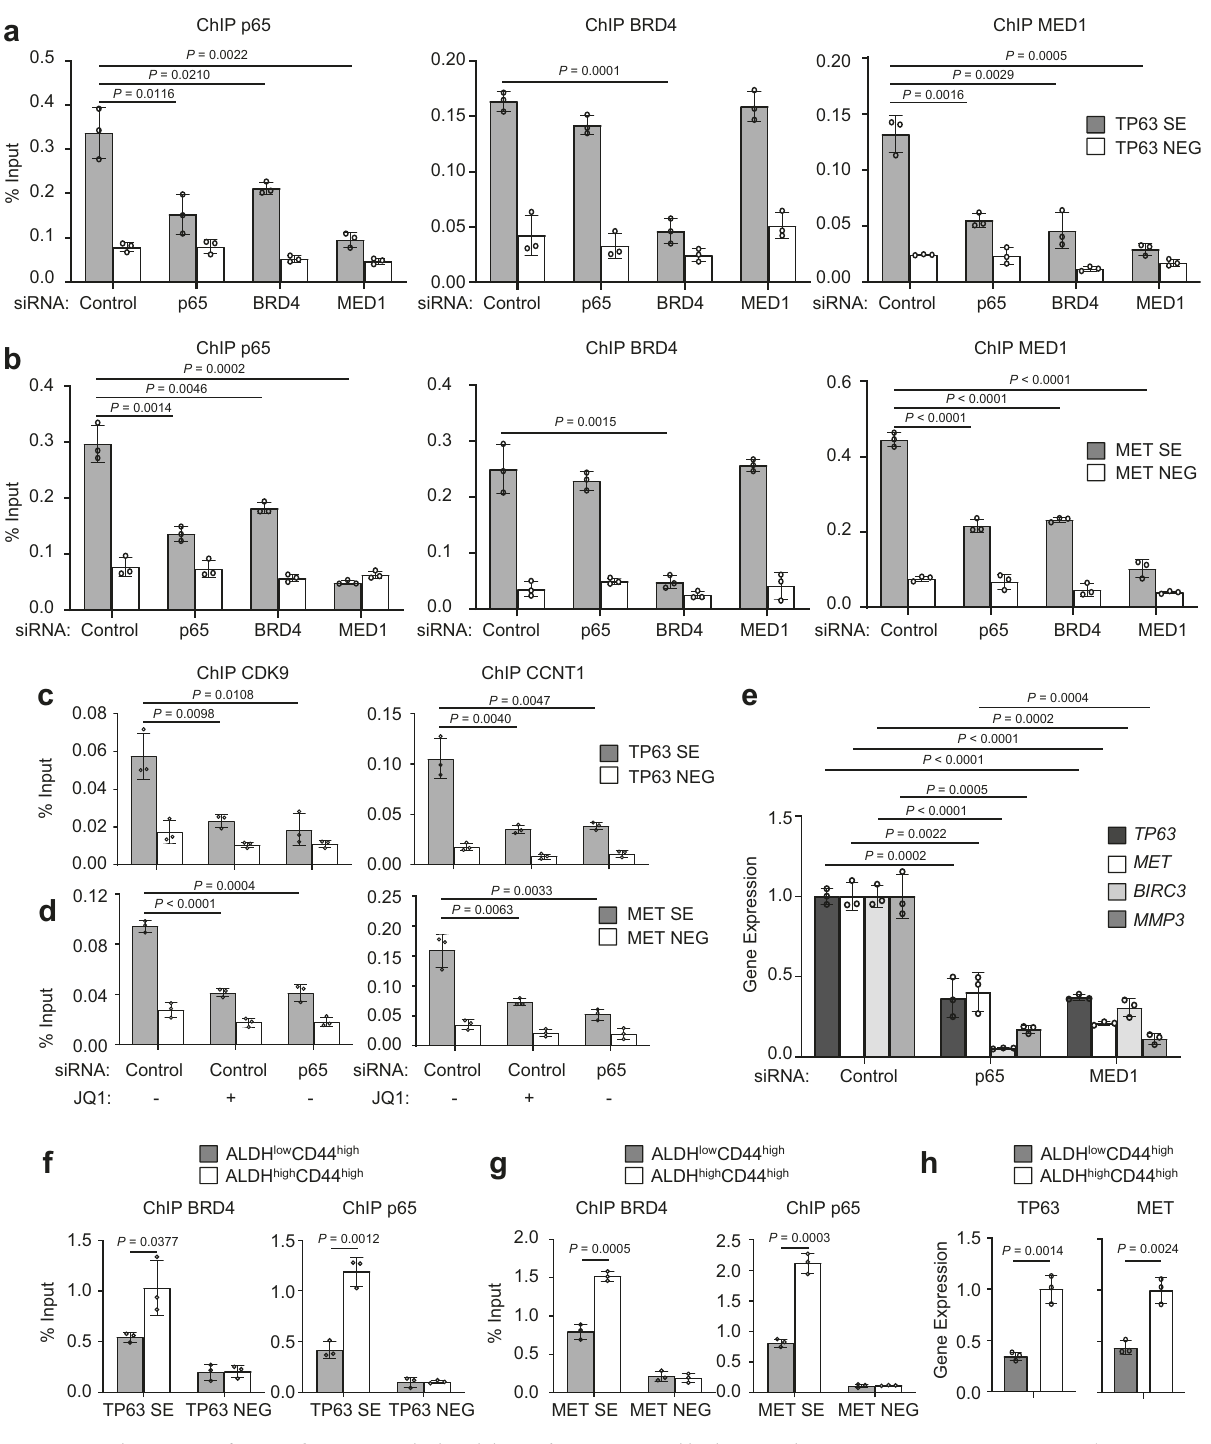
Fig. 4 BRD4 recruits MED1 and p65 to form SEs. a The knockdown of BRD4 impaired both p65 and MED1 recruitments to SEs in TP63 ( n = 3 per group). b The knockdown of BRD4 impaired both p65 and MED1 recruitments to SEs in MET ( n = 3 per group). c JQ1 treatment or p65 knockdown signi fi cantly inhibited the recruitment of both CDK9 and CCNT1 to SEs in TP63 ( n = 3 per group). d JQ1 treatment or p65 knockdown signi fi cantly inhibited the recruitment of both CDK9 and CCNT1 to SEs in MET ( n = 3 per group). e RT-qPCR showed that knockdown of p65 and MED1 signi fi cantly inhibited the expression of TP63 , MET , BIRC3 , and MMP3 ( n = 3 per group). f Increased enrichments of both p65 and BRD4 on SEs of TP63 in CSC-like cell ( n = 3 per group). g Increased enrichments of both p65 and BRD4 on SEs of MET in CSC-like cells ( n = 3 per group). h CSCs had signi fi cantly higher TP63 and MET expression levels ( n = 3 per group). Data are presented as mean values ± SD in a – m . Statistical analysis was performed using two-tailed unpaired Student ’ s t -test. The data in a – m are representative of three experiments with similar results. Source data are provided as a Source data fi